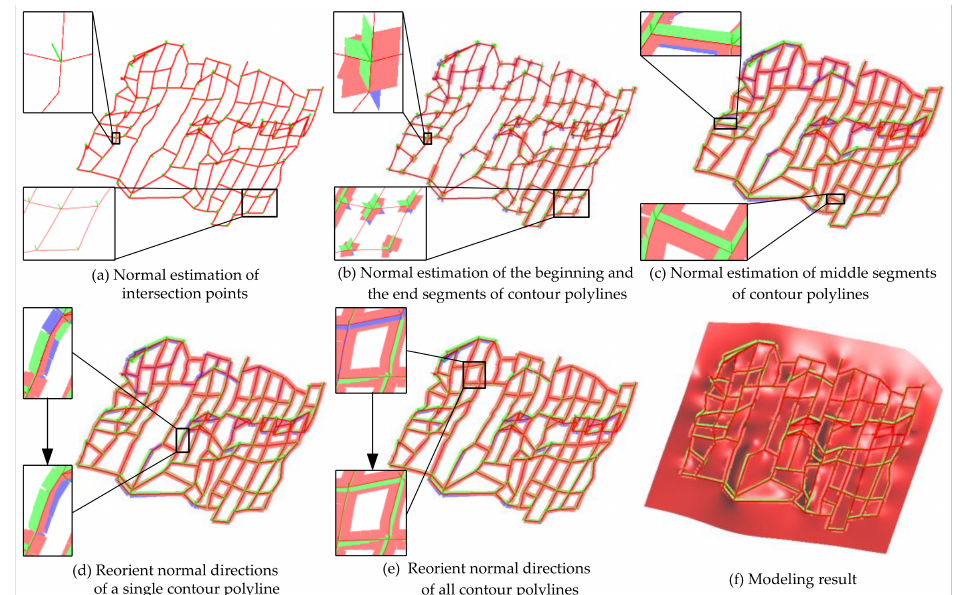
Figure 12. Experimental results of the fourth set of cross-contour polylines. ( a – c ) show the process of the normal estimation; ( d , e ) show the process of reorienting the normal directions; ( f ) shows the final modeling result.